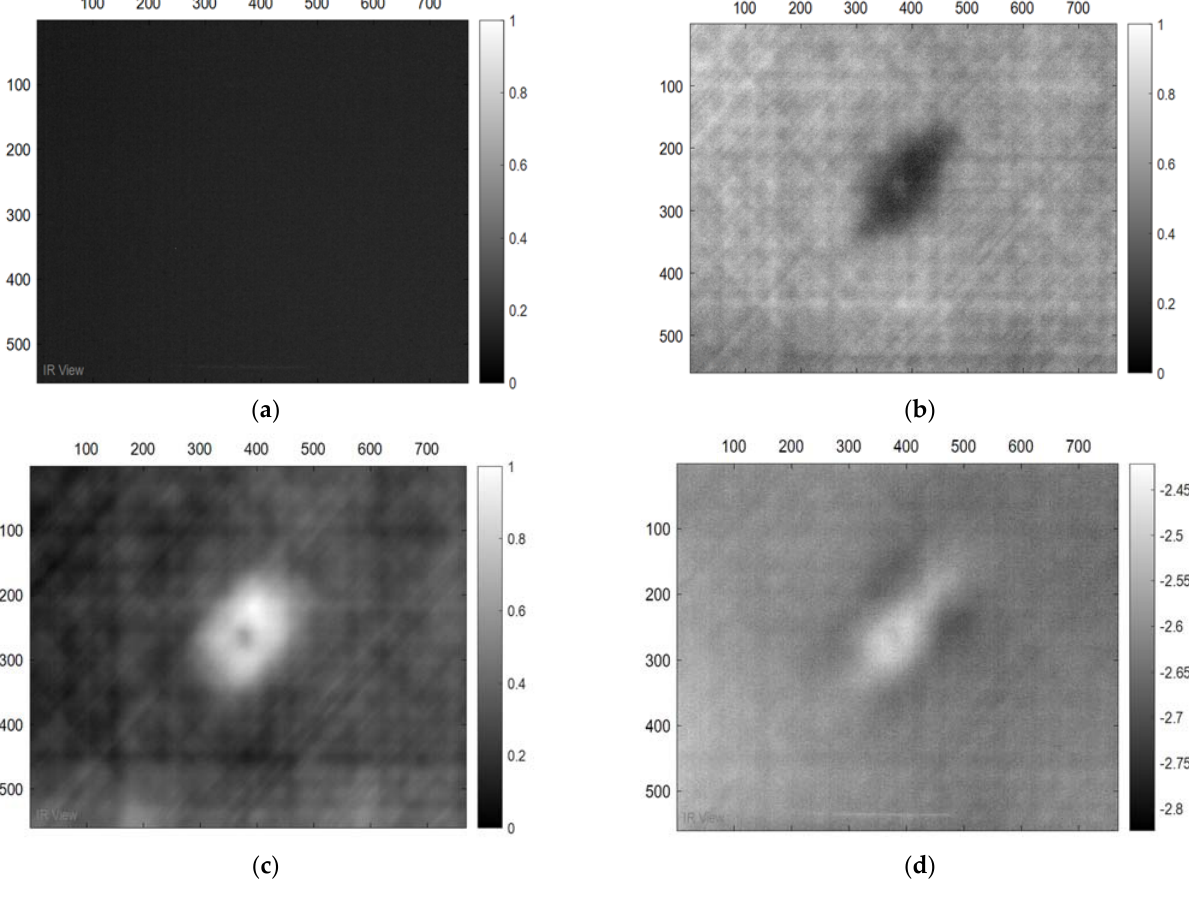
Figure 7. Image Processing Results. ( a ) Cold image. ( b ) Raw Image. ( c ) BCT Image. ( d ) PPT Image.